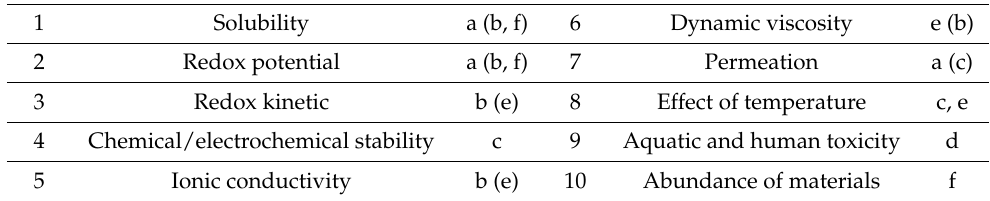
Table 1. Important parameters of electrolytes and how they relate to battery key performance indicators: (a) energy density, (b) power density, (c) lifetime, (d) environmental impact, (e) efficiency, and (f)